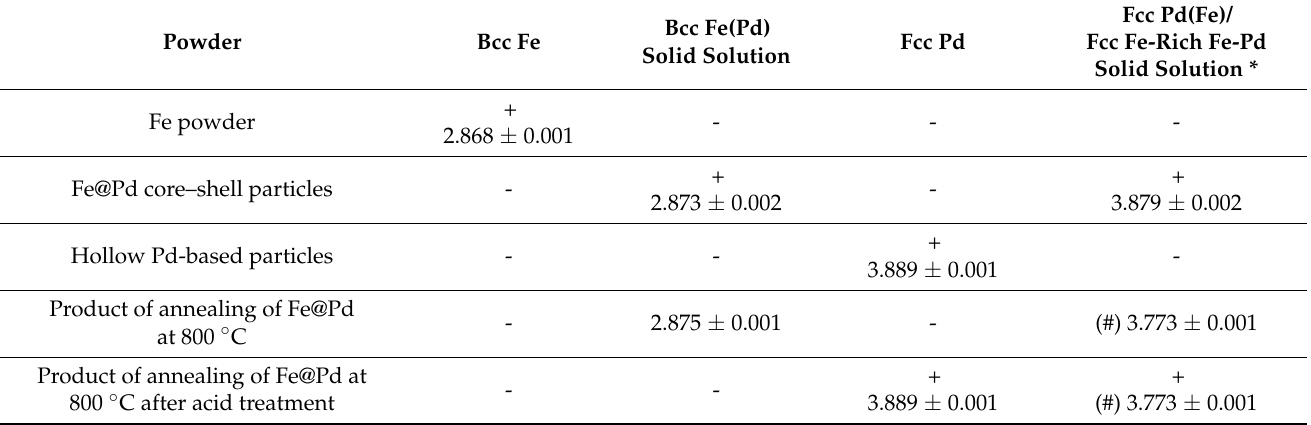
Table 1. Phases (as determined by X-ray diffraction) and their lattice parameters (Å) of the Fe-Pd alloys described in the present work. The lattice parameter of pure metallic palladium is 3.890 Å, pure metallic bcc iron—2.867 Å (bcc—body-centered cubic, fcc—face-centered cubic). Atomic radius of iron is 126 pm. Atomic radius of palladium is 137 pm.